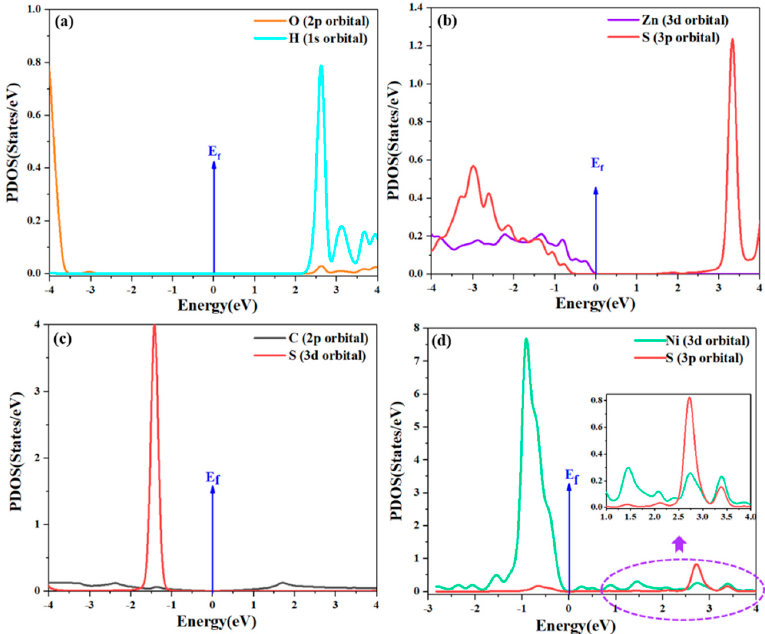
Figure 8. Partial density of states (PDOS) plots of H 2 S adsorption on: ( a ) BeO, ( b ) ZnO, ( c ) pristine graphene, and ( d ) Ni-decorated graphene sheets.